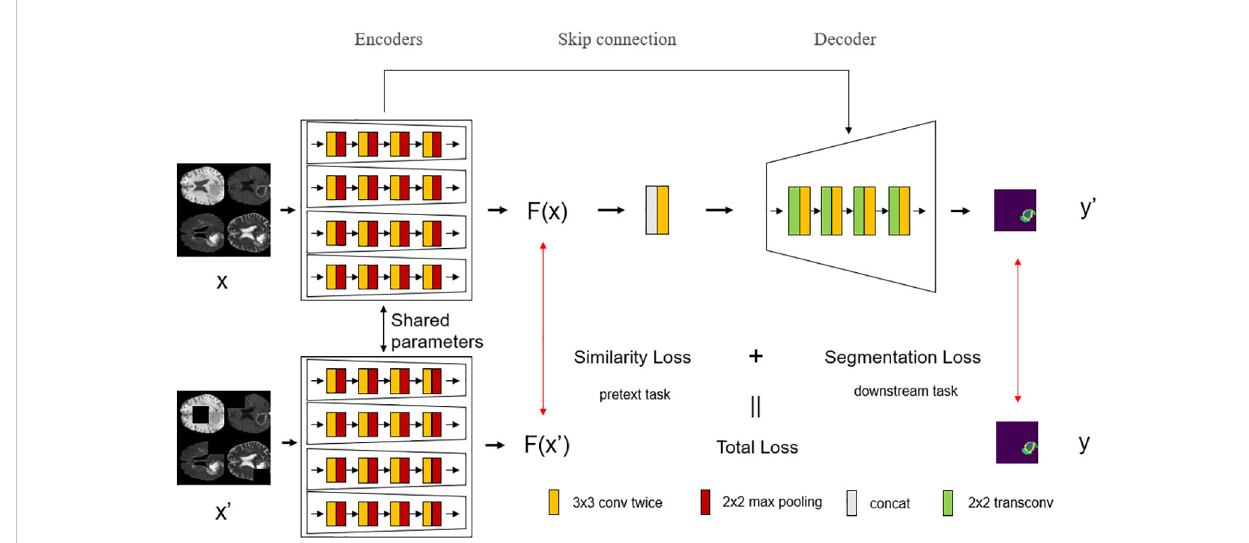
FIGURE 3 The overall structure of the model with the introduction of self-supervised learning. Self-supervised learning is introduced into the network, which divides the encoder stage into upper and lower branches, where the encoder shares parameters, and each modality of the multi-modal image input in the lower branch is randomly masked at different positions, and then trained according to the parameters of the shared encoder from the upper